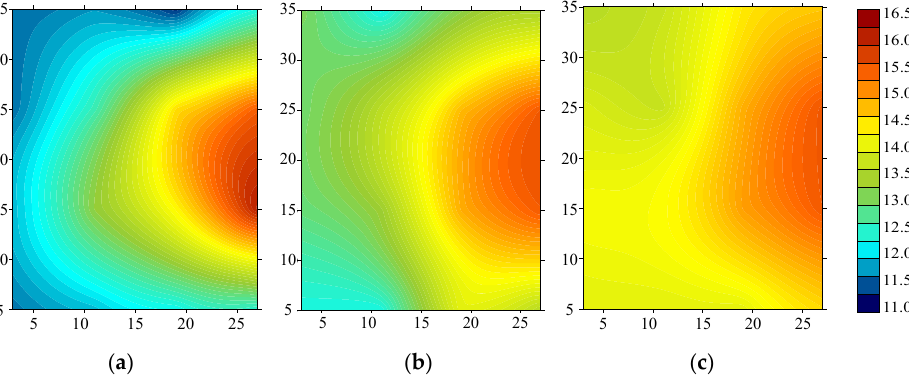
Figure 7. Dynamic distribution of pressure field in soaking of case two: ( a ) soaking for 10 min; ( b ) soaking for 5 h; ( c ) soaking for 10 h.